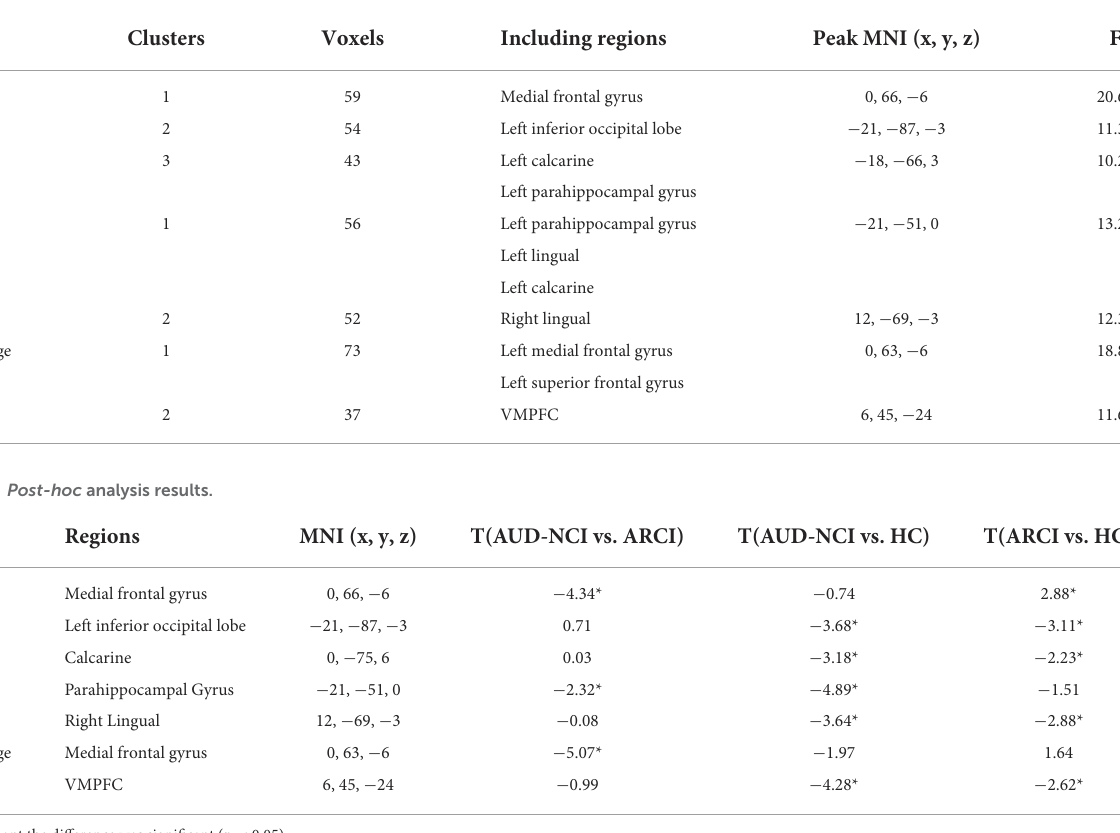
TABLE 2 ANOVA results of FCD.